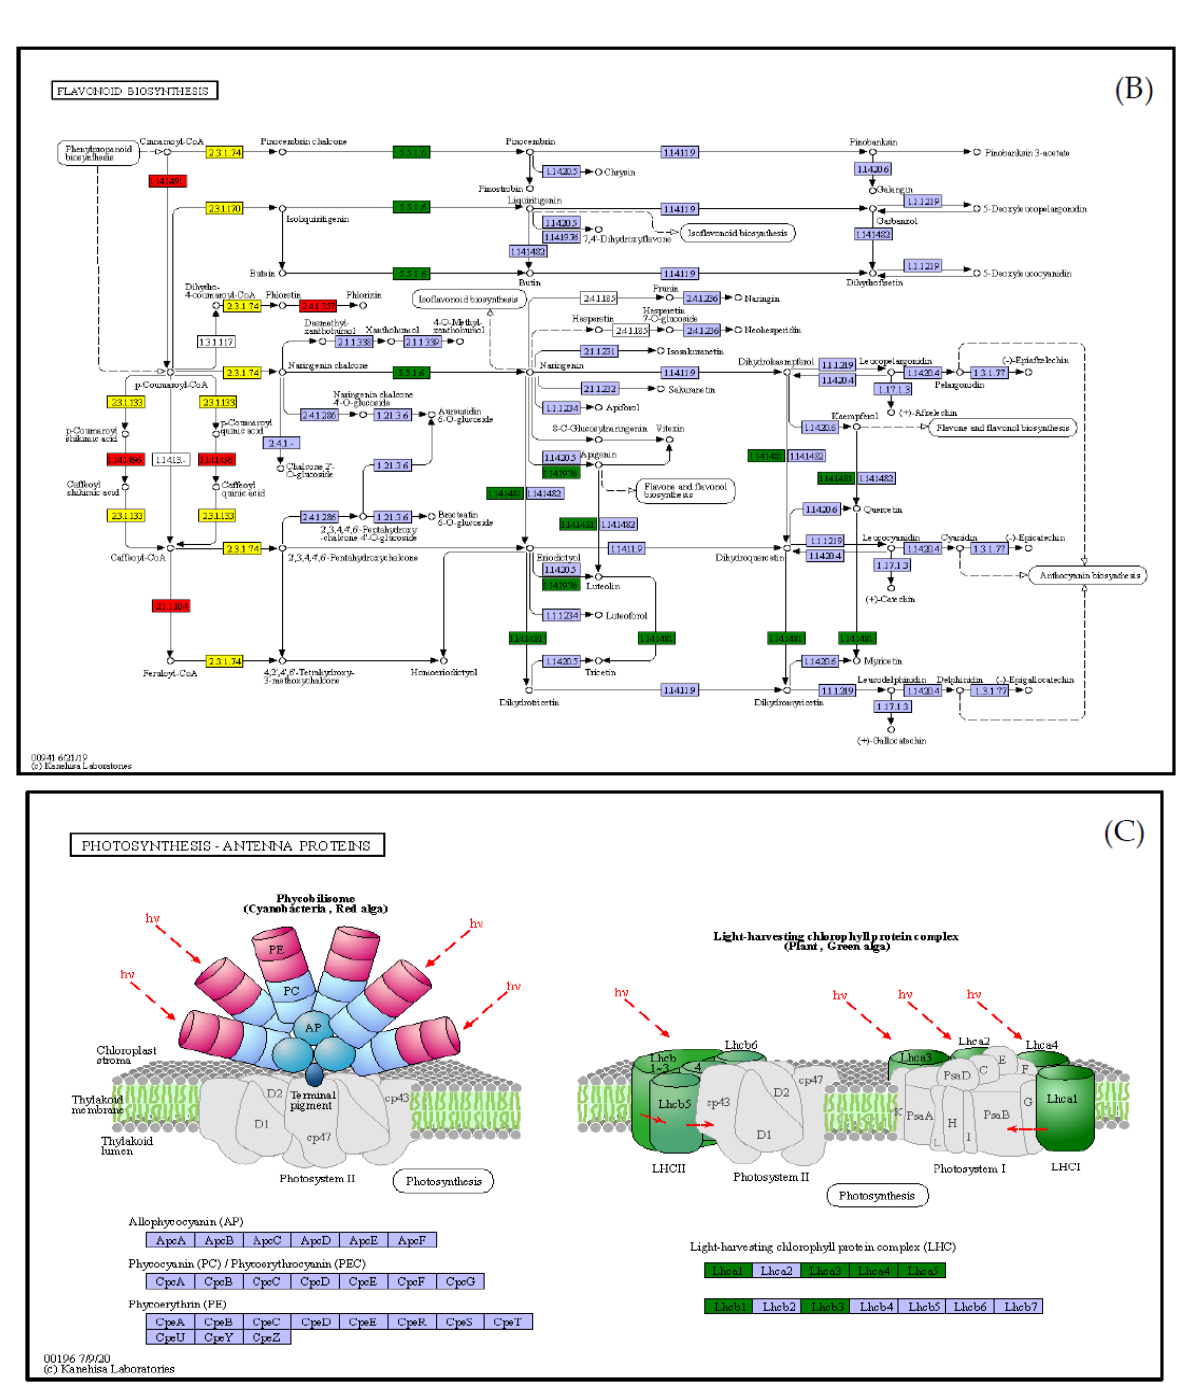
Figure 11. The differentially expressed genes mapped to the KEGG pathway diagram. ( A ) Phenylpropanoid biosynthesis. ( B ) Flavonoid biosynthesis. ( C ) Photosynthesis-antenna proteins. The green color represents a significant downregulation of the gene or metabolite, the red color represents a significant upregulation of the gene or metabolite, and the yellow color represents a gene that is both upregulated and downregulated.